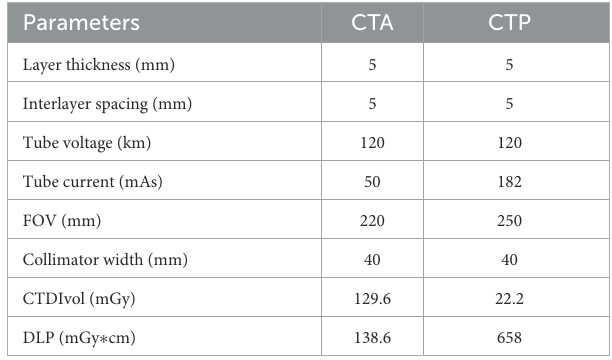
TABLE 2 CTP and CTA scan parameters.